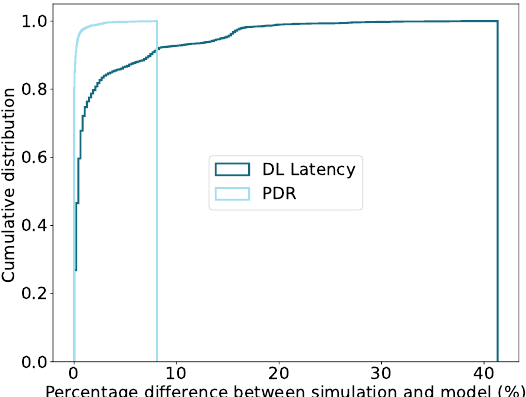
Percentage difference between simulation and model Figure 6. Cumulative distribution of difference in model and simulation results for both the DL latency and PDR metrics.